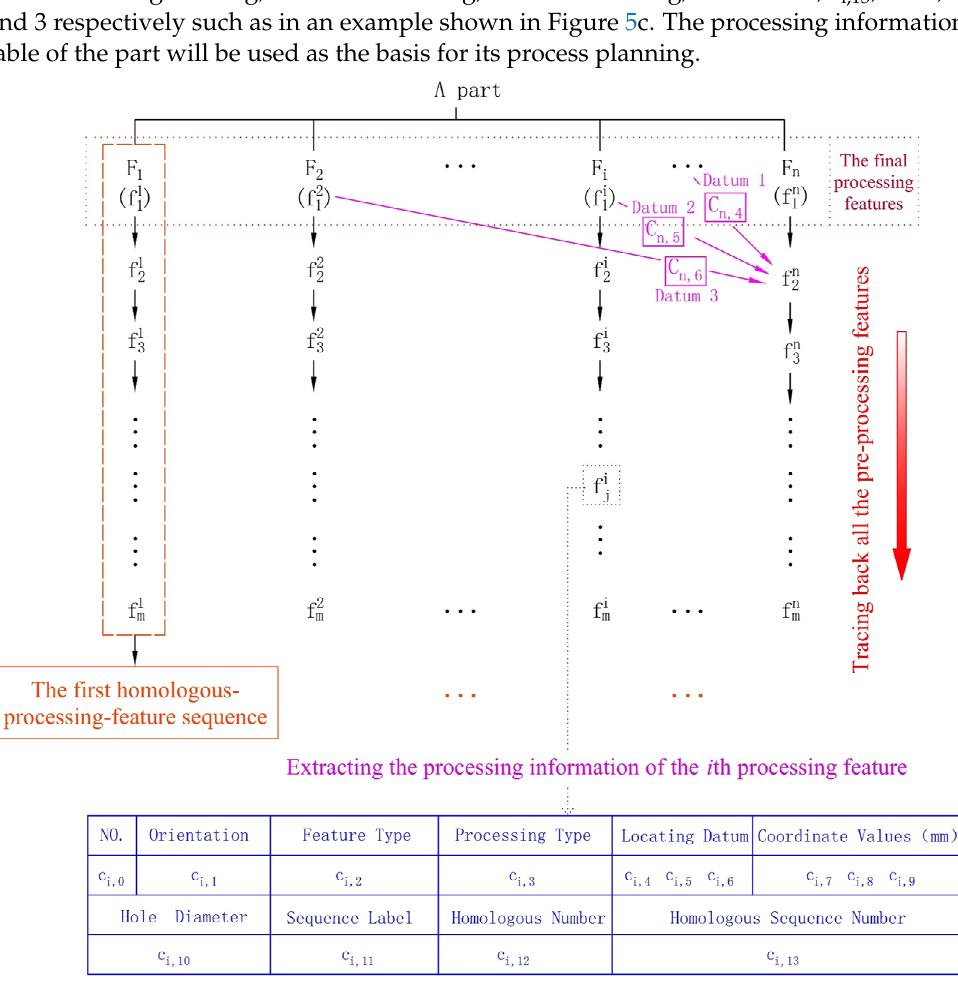
Figure 6. Schematic diagram of the establishment of the processing information table of the machined part.